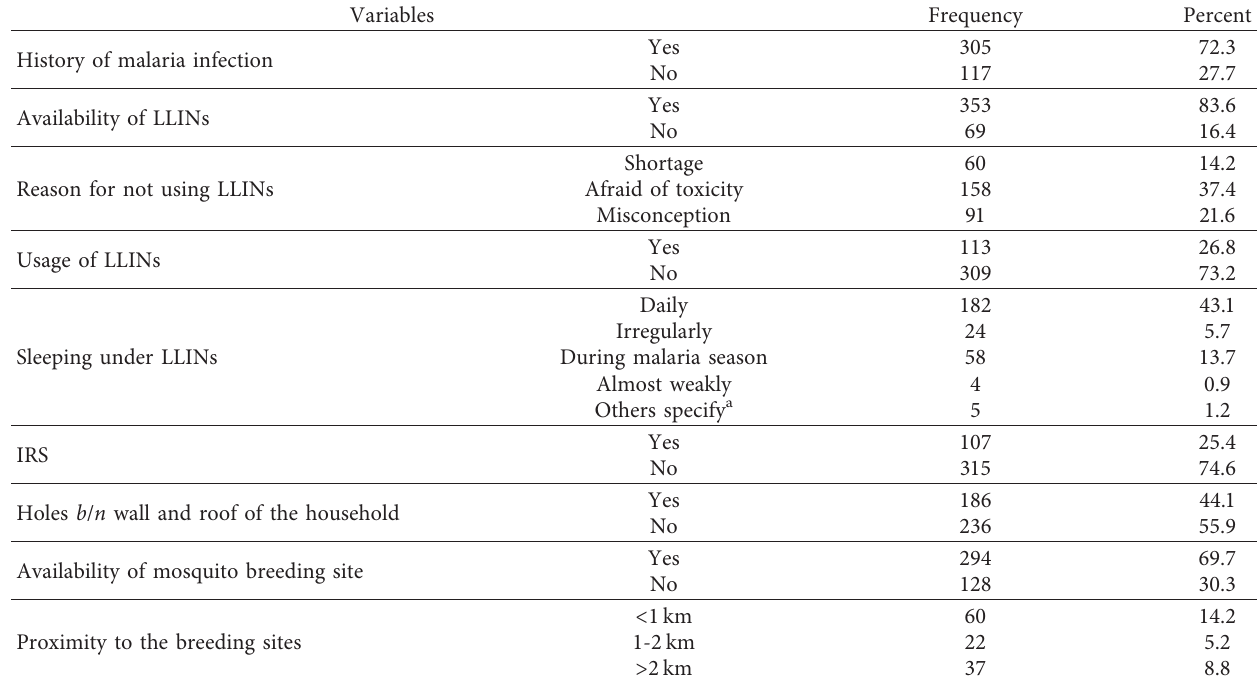
Table 3: Factors that contribute to the transmission of malaria infection in Shewa Robit, Ethiopia ( n � 422).